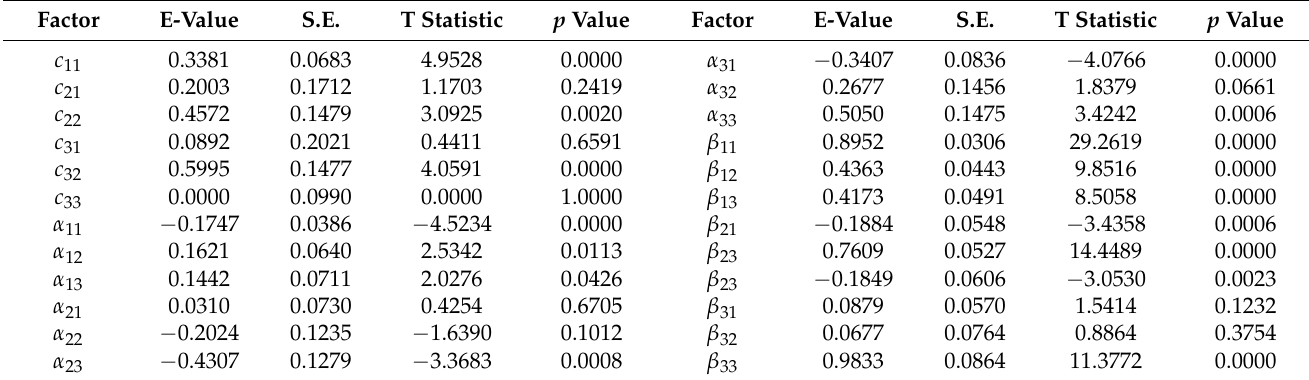
Table 9. BEKK variance equation estimation results in the first